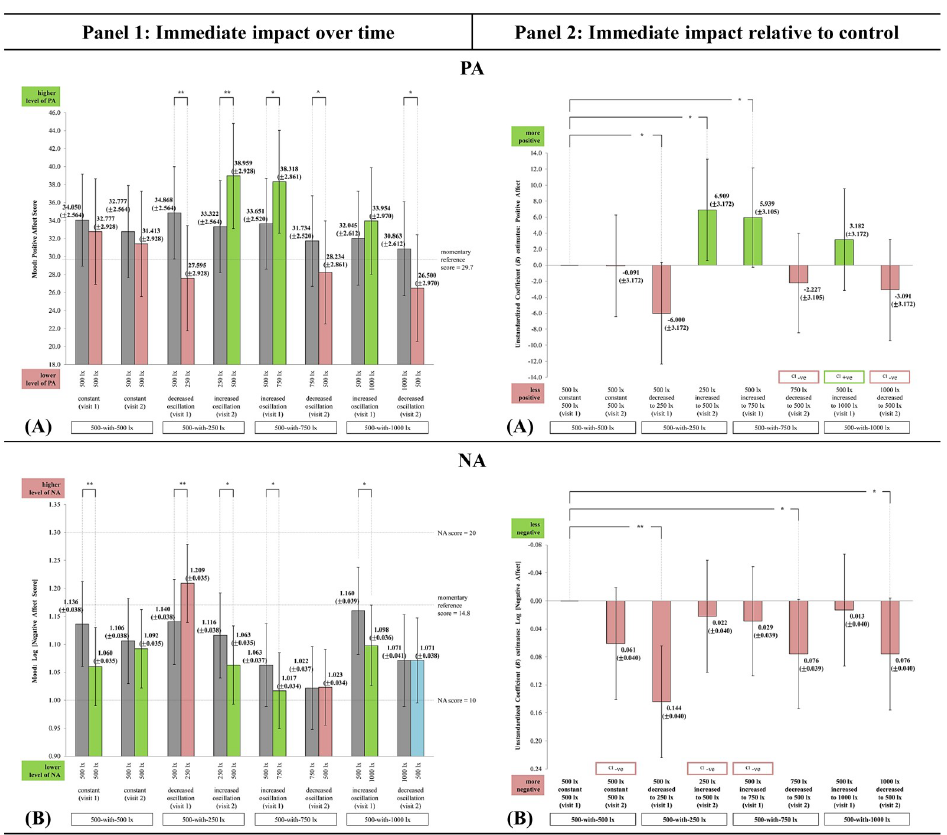
Fig 7. The immediate impact observed in PA and NA across the light-settings. (A) PA. (B) NA. (7A–7B, panel 1) Immediate change over time in all light-settings: Bars represent Estimated Marginal Means (EMM) with Standard Errors (SE); whiskers 95% confidence interval (CI); ��� p < 0.001, �� p < 0.01, � p < 0.05, ^ p < 0.06. Dark grey bar specifies EMM at TP 1 . Green bar specifies EMM at TP 2 (supportive change). Red bar specifies EMM at TP 2 (unsupportive change). Light blue bar specifies EMM at TP 2 (no change). (7A–7B, panel 2) Immediate impact of each light-setting relative to control: Bars represent Unstandardized Coefficient ( B ) with Standard Errors (SE); whiskers 95% CI; ��� p < 0.001, �� p < 0.01, � p < 0.05, ^ p < 0.06. Green bar specifies light-setting as more supportive than control. Red bar specifies light-setting as less supportive than control. (S2 Fig) The chronological order of each light-setting’s EMM Δ for PA and NA. It is recommended to be referred along with Figs 7A–7B to improve the comprehension between panel 1 and 2. Light-setting with EMM Δ chronologically ordered above than the control (S2 Fig) corresponds with the direction of the B estimate bar as being more supportive than control (Figs 7A–7B, panel 2).